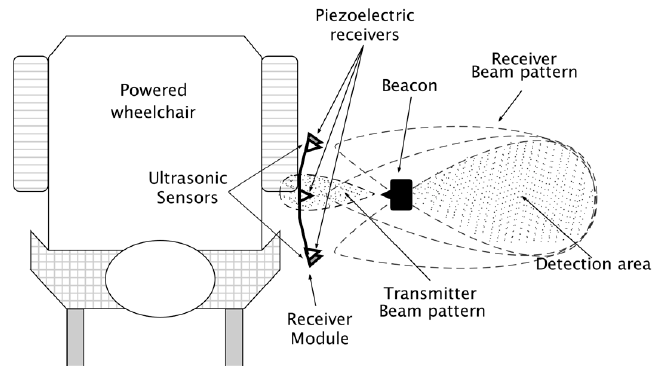
Figure 2. Detection area beside the powered wheelchair for AP identification. Beam patterns converge at the center of where the person is expected to walk.